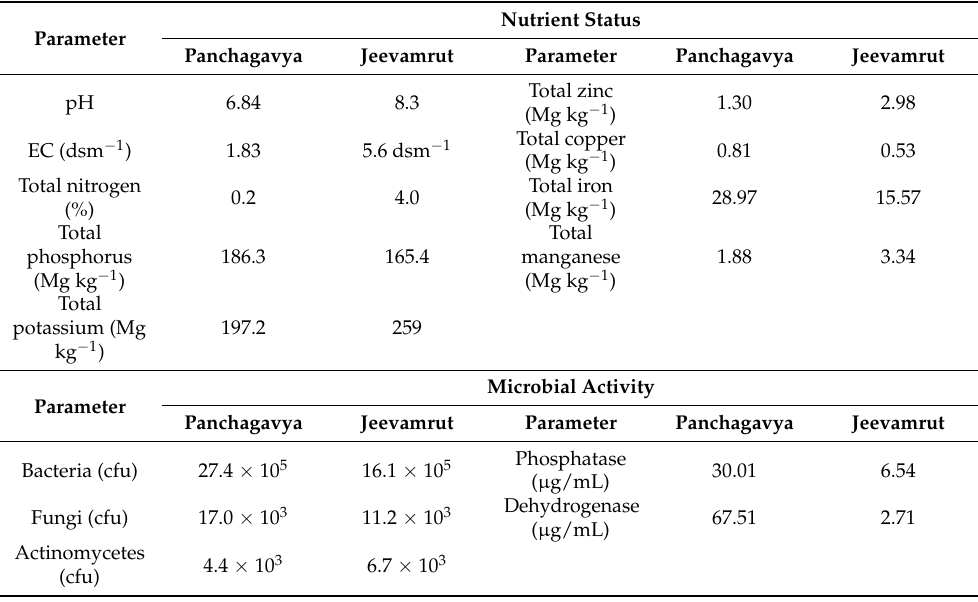
Table 2. Nutrient status and microbial load levels in panchagavya and jeevamrut.